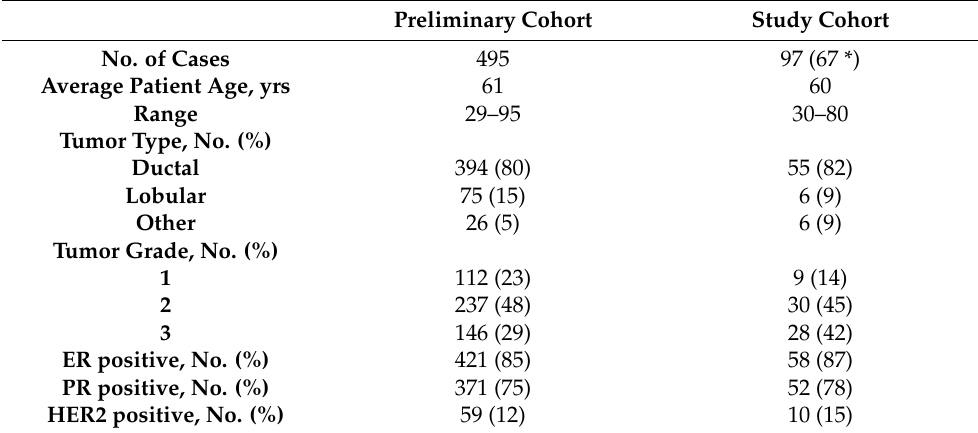
Table 1. Overview of the clinicopathological features for the preliminary ( n = 495) and study ( n = 97) cohorts. Tumor data for the study cohort pertain to the 67 primary tumors. Preliminary Cohort Study